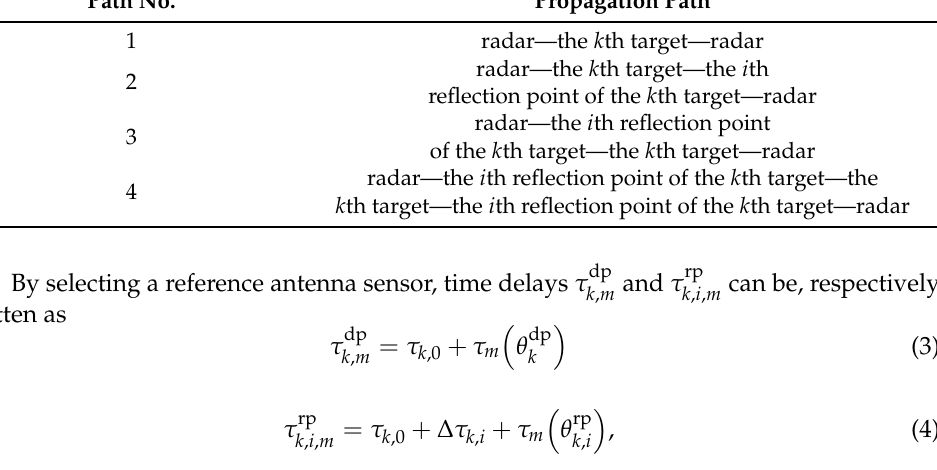
Table 1. Multipath propagation of the k th target with its i th reflecting path. Path